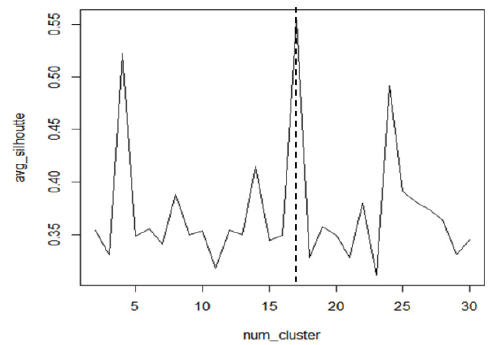
Figure 8. Average silhouette value for each pattern.